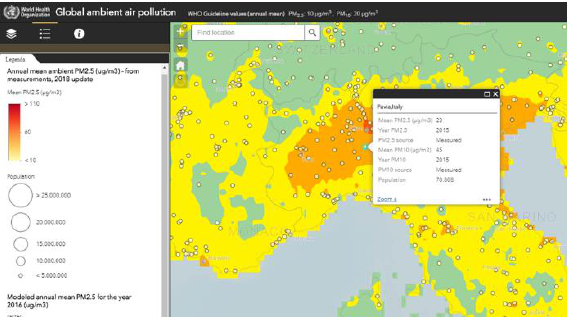
Figure 1. The WHO online map on air pollution and people’s exposure for Pavia, Northern